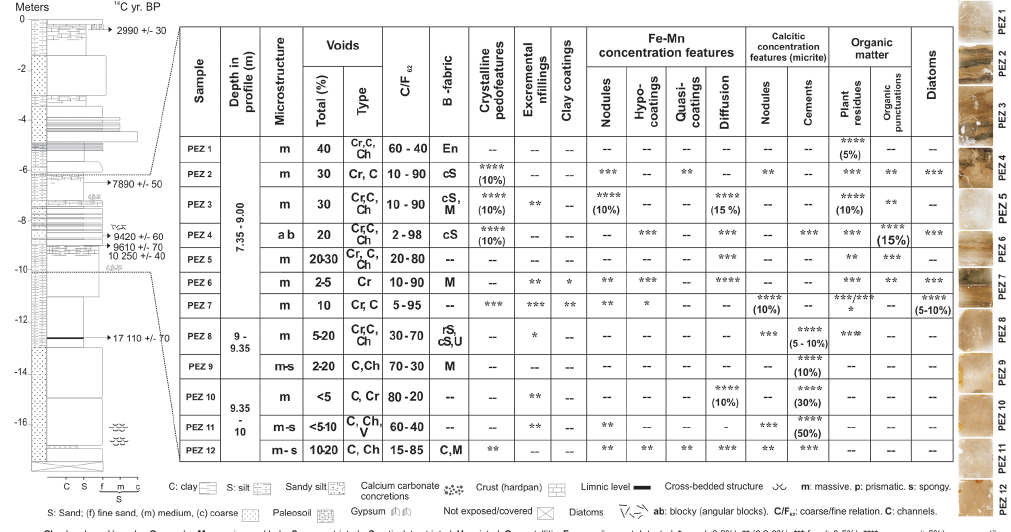
Fig. 4. Alluvial sequence field log at Puente El Zampal study site (Arroyo Anchayuyo) and micromorphology of the ca. 10ka